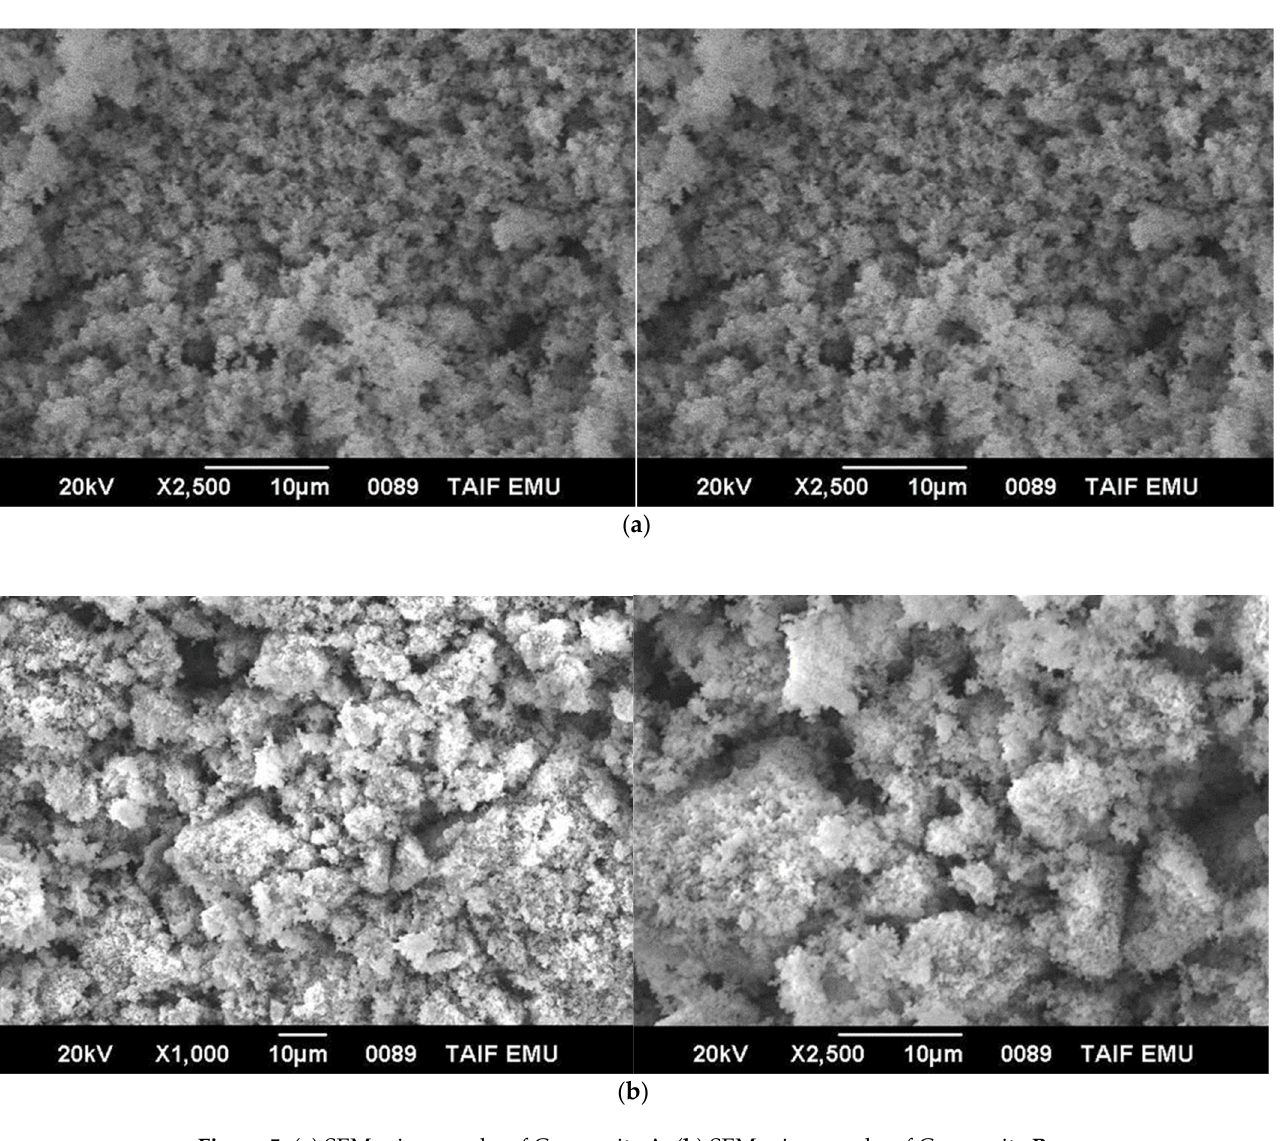
Figure 4. ( a ) SEM micrographs of Solid Mixture A: [Fe(NH 2 CONH 2 ) 6 ]Cl 3 and [Cr(NH 2 CONH 2 ) 6 ]Cl 3 . ( b ) SEM micrographs of Solid Mixture B: [Fe(NH 2 CONH 2 ) 6 ]Cl 3 and [Cr(NH 2 CONH 2 ) 6 ](NO 3 ) 3 .